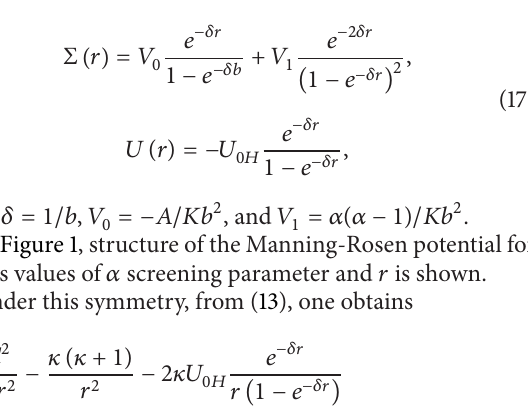
Figure 1: The variation of the Manning-Rosen potential according to various values of 𝛼 screening parameter and ( 𝛿 = 1/𝑏 = 0.025 , 𝐴 = 2𝑏 , 𝐾 = 2 ). ̃𝛽 2 = (𝑀+𝐸 )(𝑀−𝐸 +𝐶 ) . where ̃𝛾 = 𝐸 𝑛𝜅 −𝑀−𝐶 and 𝑛𝜅 𝑛𝜅 ps ps −̃𝑙 ̃𝑙 + 1 Also, 𝜅 = and 𝜅 = for 𝜅 < 0 and 𝜅 > 0 ,